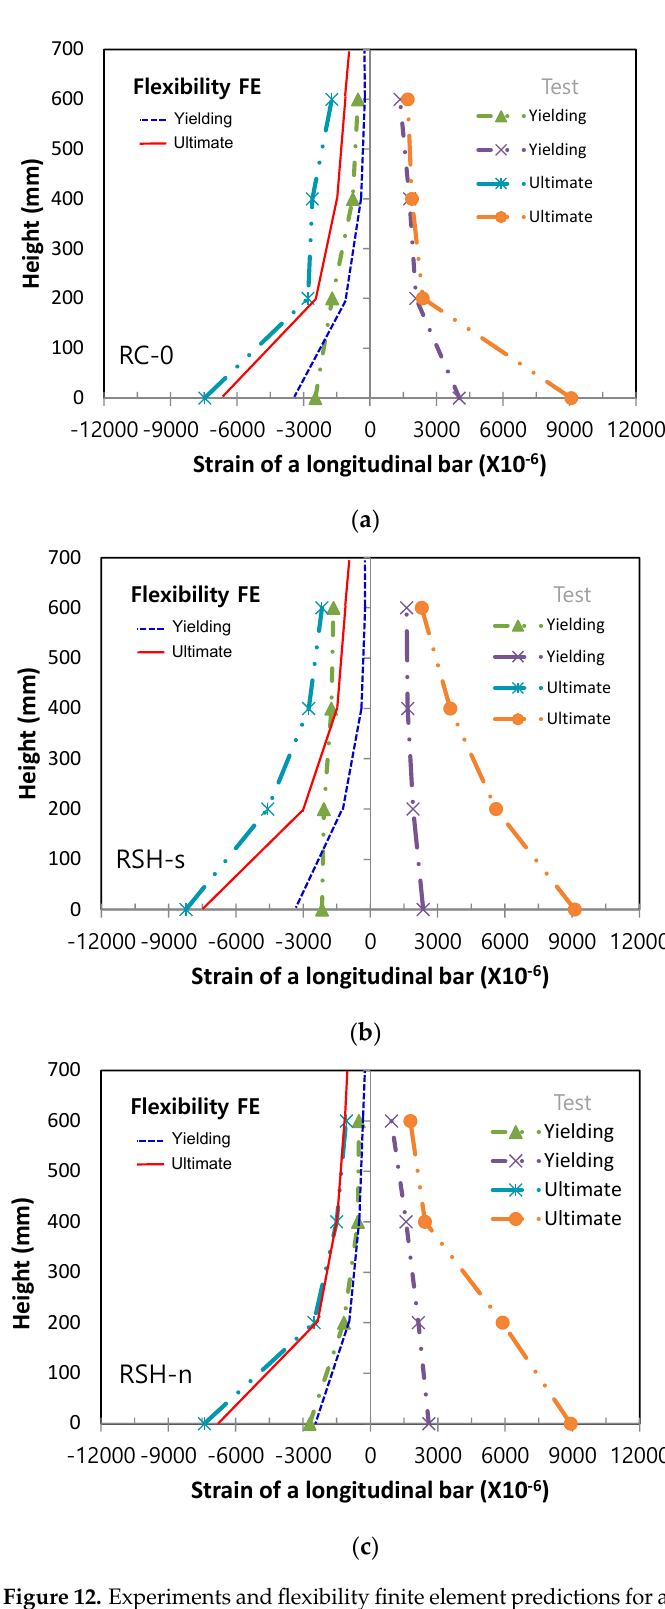
Figure 12. Experiments and flexibility finite element predictions for axial strains of steel bars, ( a ) RC-0, ( b ) RSH-s, ( c ) RSH-n.